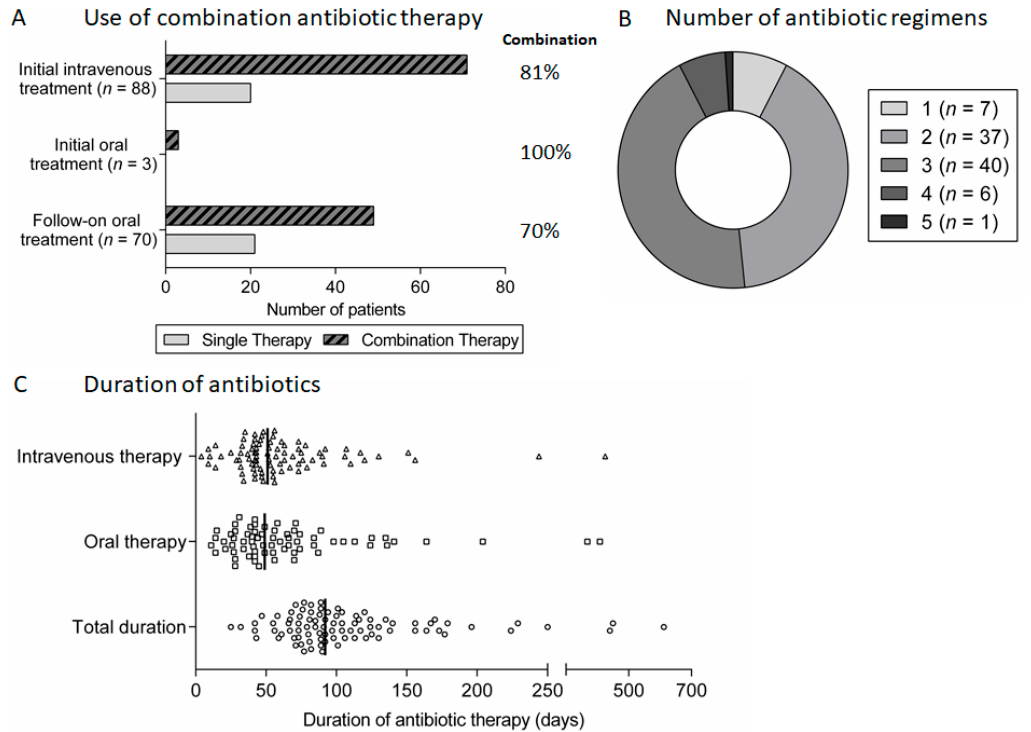
Figure 4. Antibiotic therapy for spondylodiscitis: ( A ) proportion of patients treated using combination antibiotic regimens during initial intravenous or oral therapy and follow-on oral therapy after initial intravenous therapy; ( B ) the number of different antibiotic therapy regimens used in patients treated for spondylodiscitis; and ( C ) scatter plot of the duration of intravenous, oral and total antibiotic therapy for spondylodiscitis, with lines indicating the median duration.